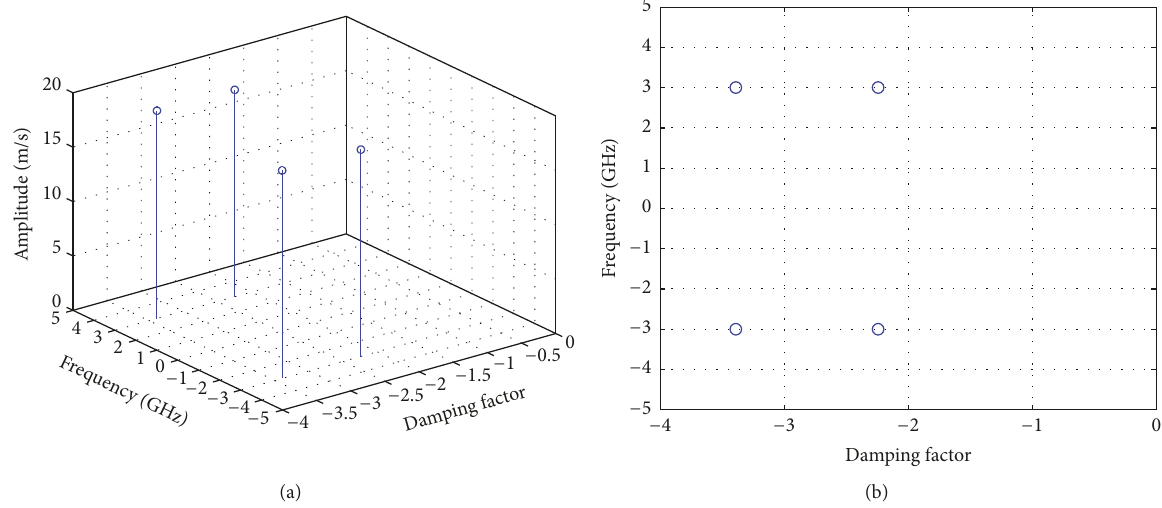
Figure 14: Using proposed enhanced MP method: (a) pole-residue relationship and (b) frequency versus damping factor.